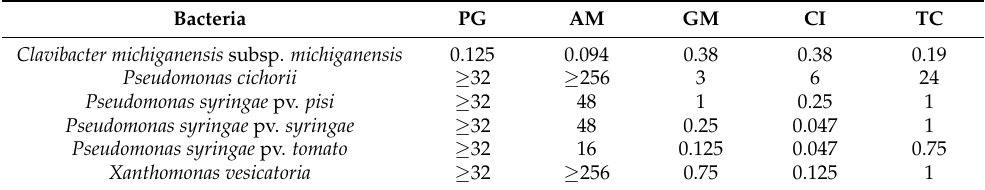
Table 3. Minimum inhibitory concentrations (expressed in µ g · mL − 1 ) of conventional antibiotics (for clinical use) against the horticultural pathogens.